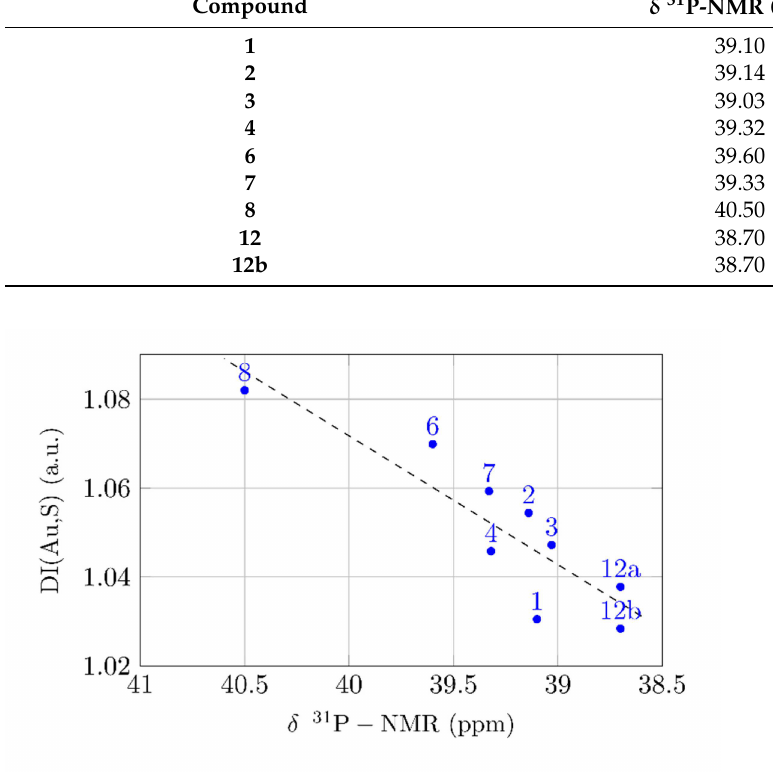
Figure 6. Interdependence of δ 31 P-NMR and the delocalization index between the Au and S atoms, which shows the influence of thiolate ligands on the electronic landscape of the trans phosphine